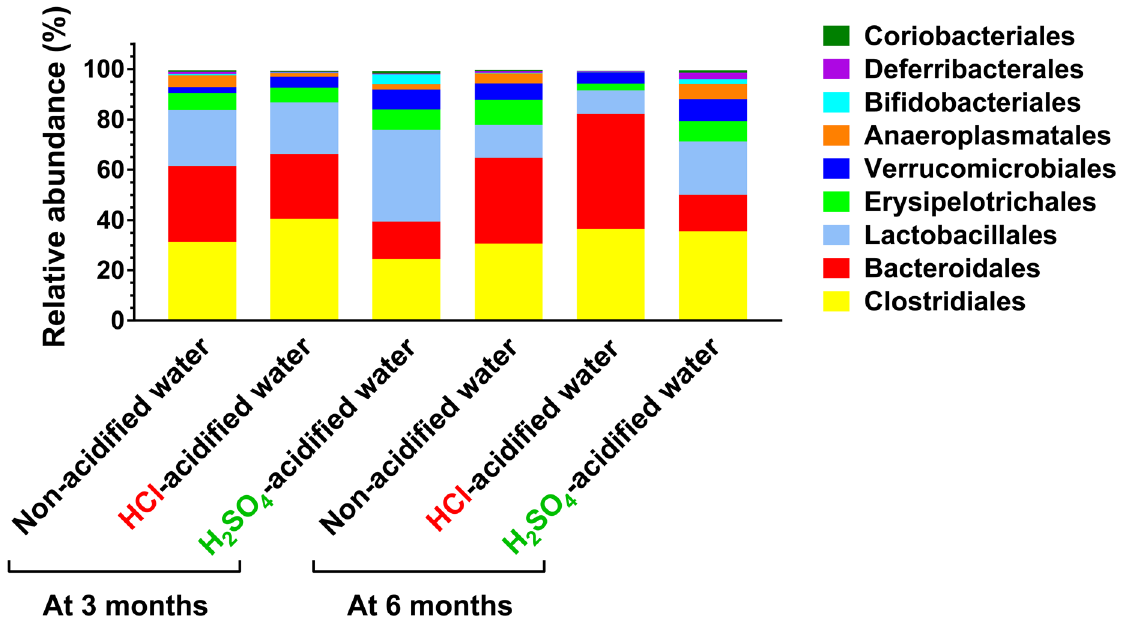
Figure 3. Representation of bacterial orders in the gut microbiota of 129S6/SvEv male mice kept on non- acidified drinking water or received drinking water acidified with H 2 SO 4 or HCl from weaning (postnatal day 21). Fecal pellets were collected at three and six months of age to analyze the gut microbiota by16S rRNA gene sequencing. The stacked bar plot shows the percent composition of the gut microbiota at the order taxonomic level (averaged from 5 mice from 4 to 5 different cages for each